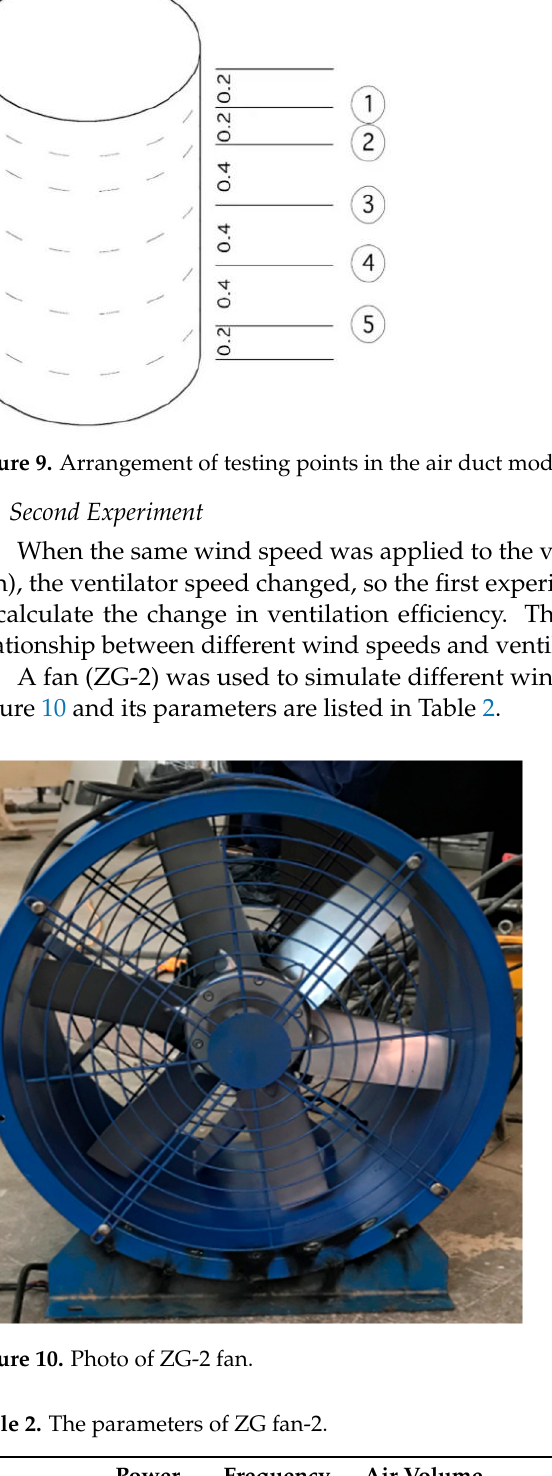
Table 2. The parameters of ZG fan-2.